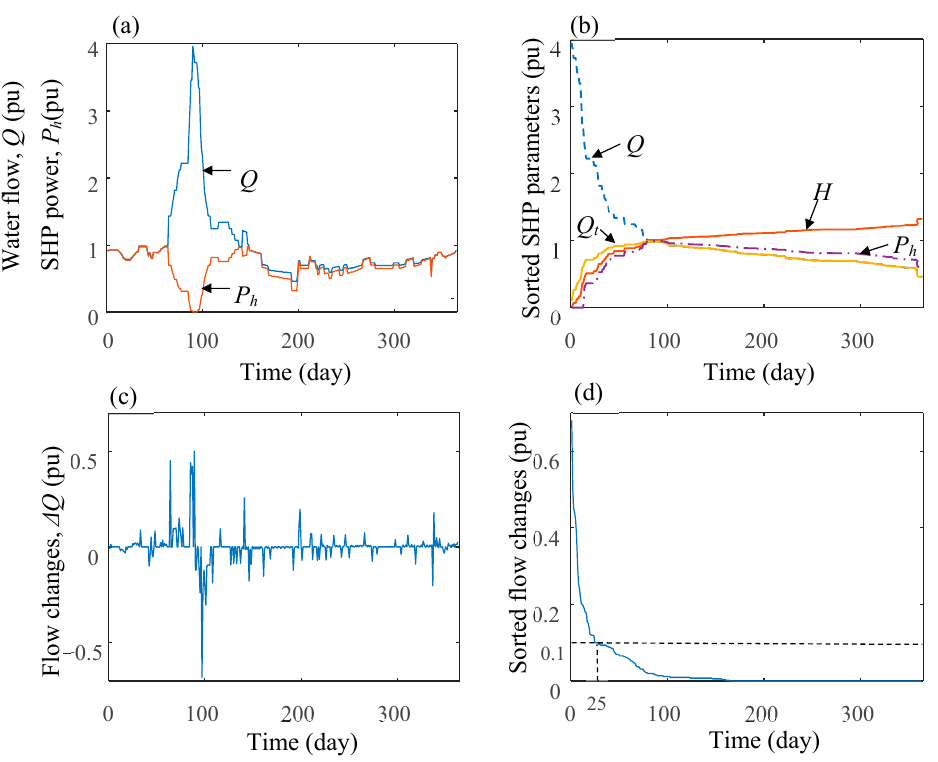
Figure 17. Annual performance curves of ( a ) water flow of river; ( b ) sorted SHP parameters ( Q —river flow, H —water head, Q t —turbine discharge, P h —SHP output power); ( c ) per unit day-to-day flow changes; and ( d ) absolute values of per unit day-to-day flow changes sorted in descending order.